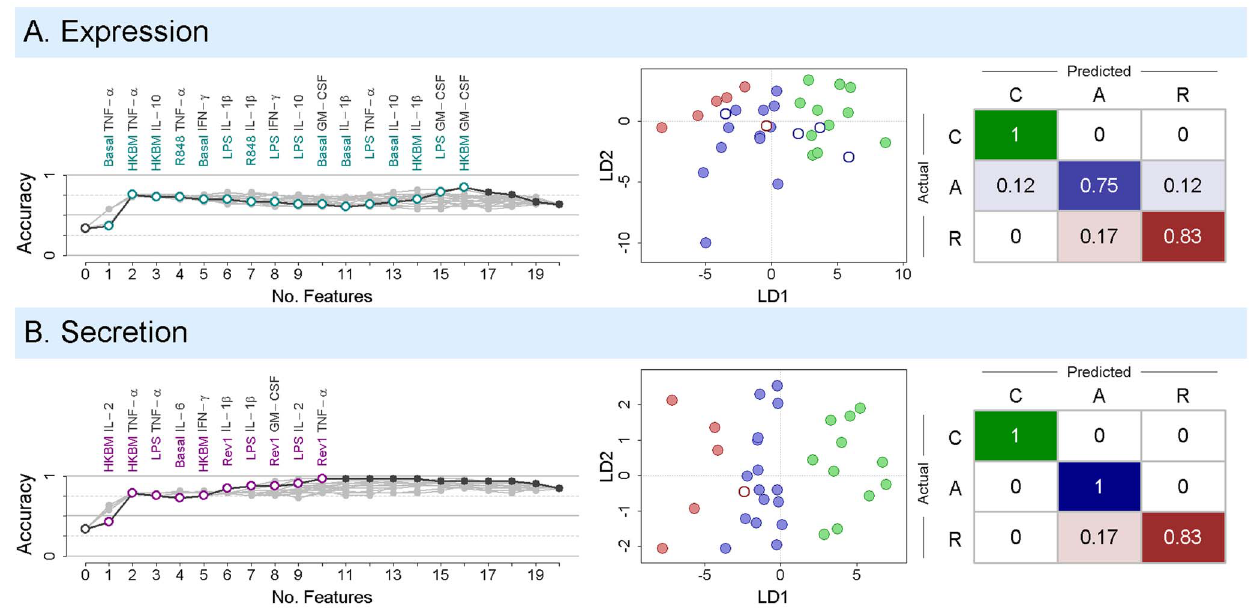
Figure 6. Model selection and classification results. Response variables were selected and a linear discriminant classifier was trained using the transformed gene expression (A) or cytokine secretion data (B). The left panels show the results of 20 model selection runs, with the best-performing classifier highlighted in color. The variable included after each step in the forward selection is listed for the optimal model. Zero features is equivalent to random guessing. The center column shows all 33 patients after being mapped by the first (LD1) and second (LD2) linear discriminant functions used by the best-performing classifier. Classification performance is summarized by the confusion matrix on the right. This matrix gives the proportion of (C)ontrol, (A)cute, and (R)elapse patients that were correctly (on-diagonal) and incorrectly classified (off-diagonal). Figure S1 PBMC cytokine secretion after stimulation measured by multiplex immunoassay. Secretion of IL-1 b ,